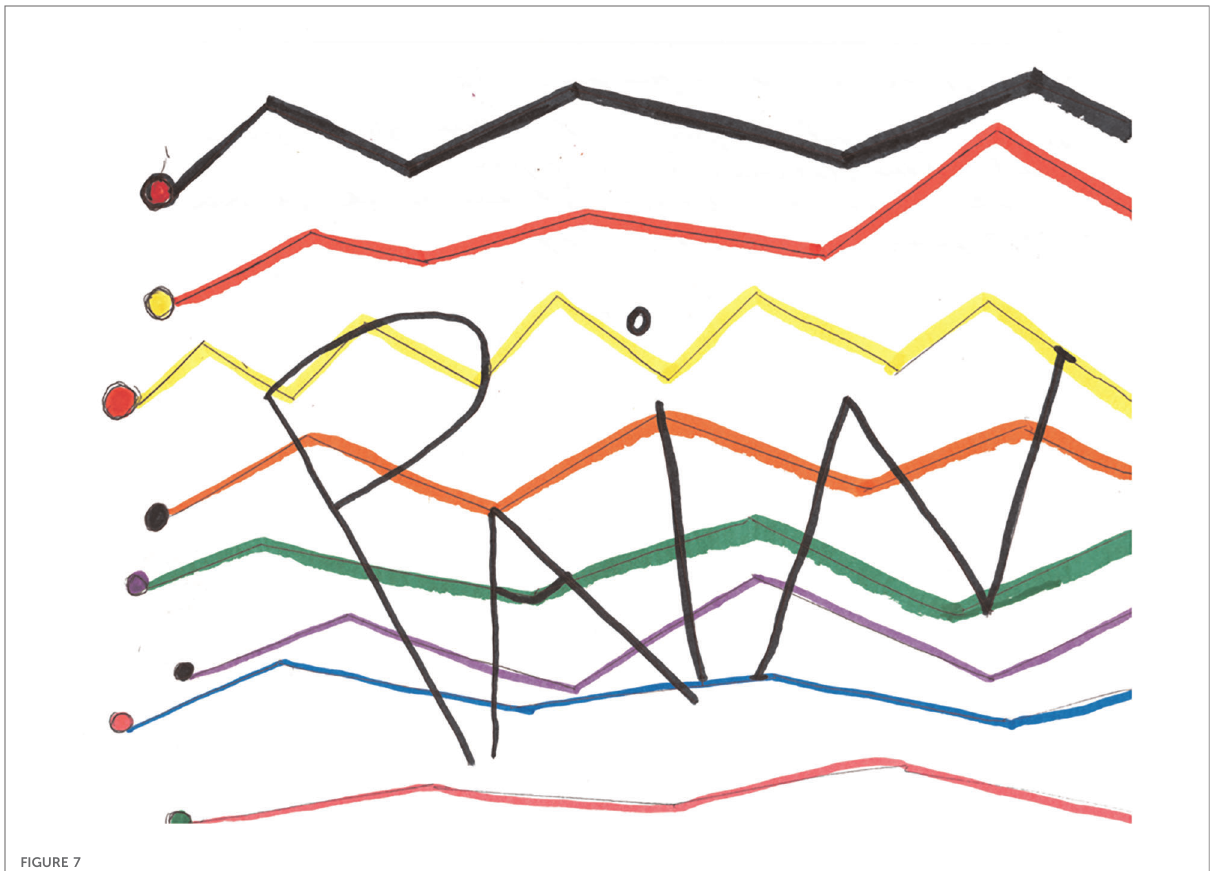
FIGURE 7 Pain as colored zigzag